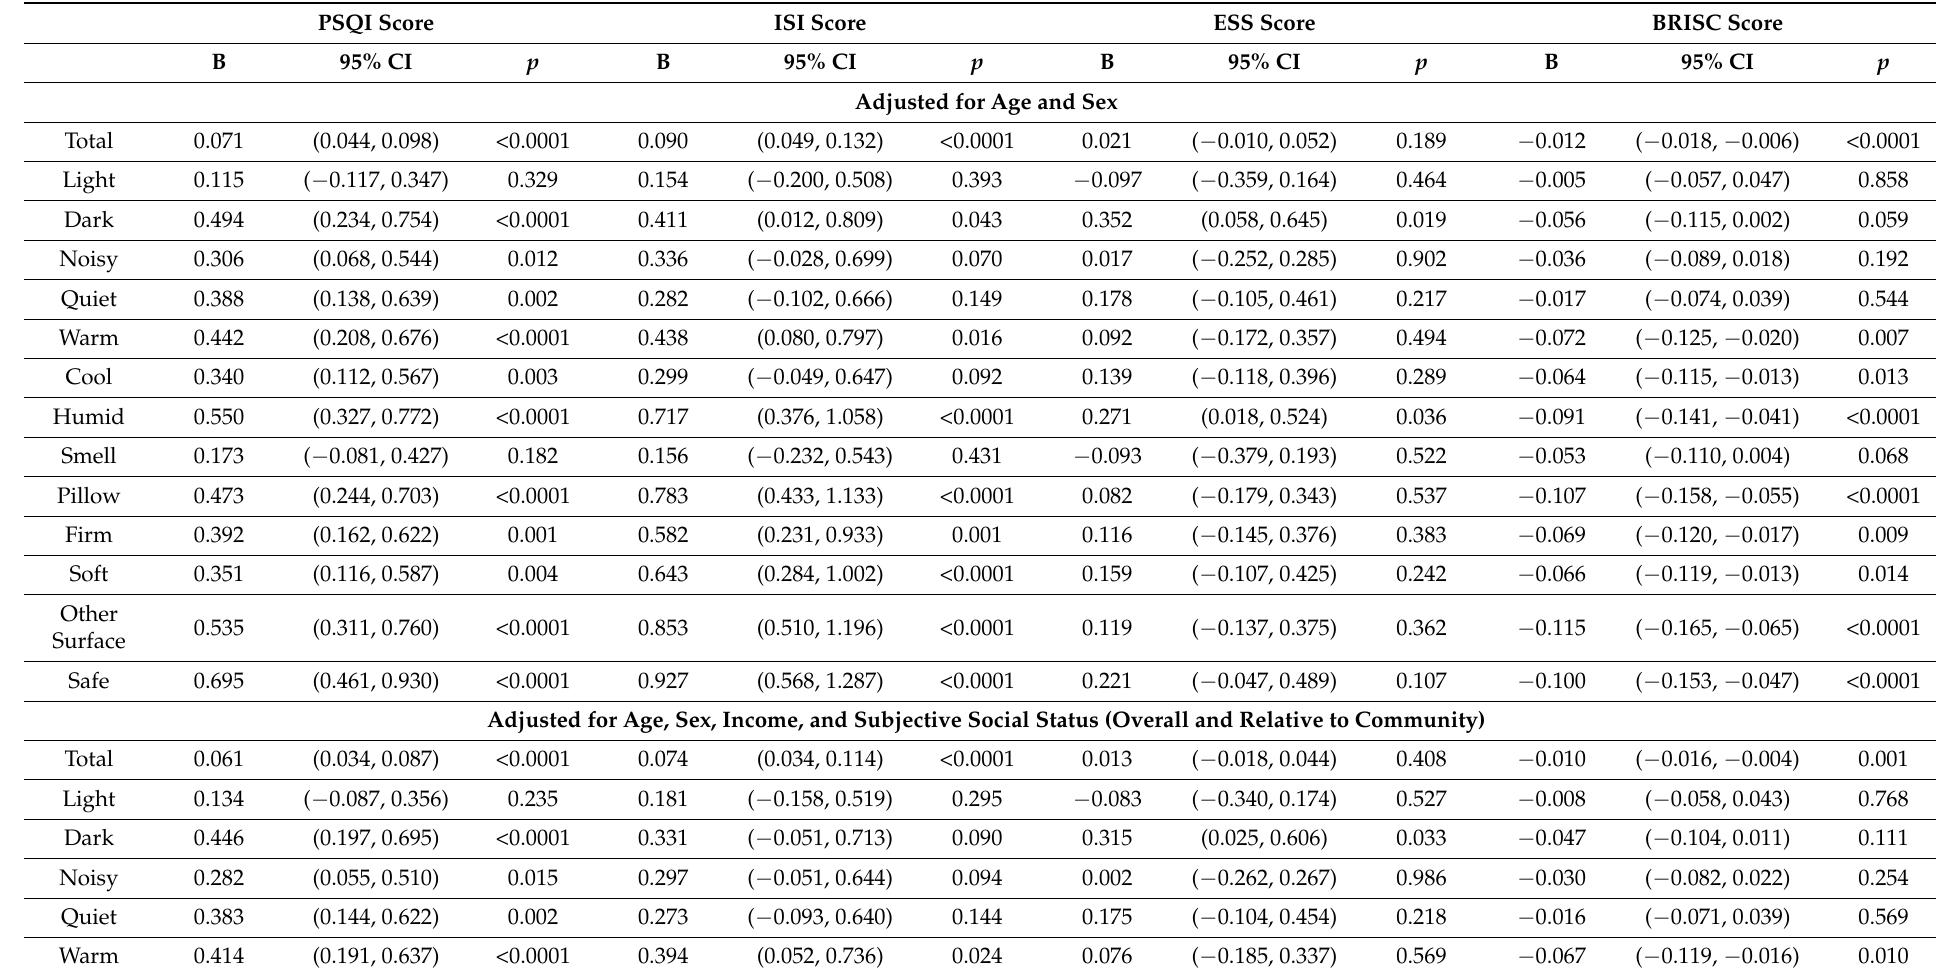
Table 3. Relationships between ASE Items and Sleep Quality, Insomnia Severity, Daytime Sleepiness, and Sleep Control. PSQI Score ISI Score BRISC